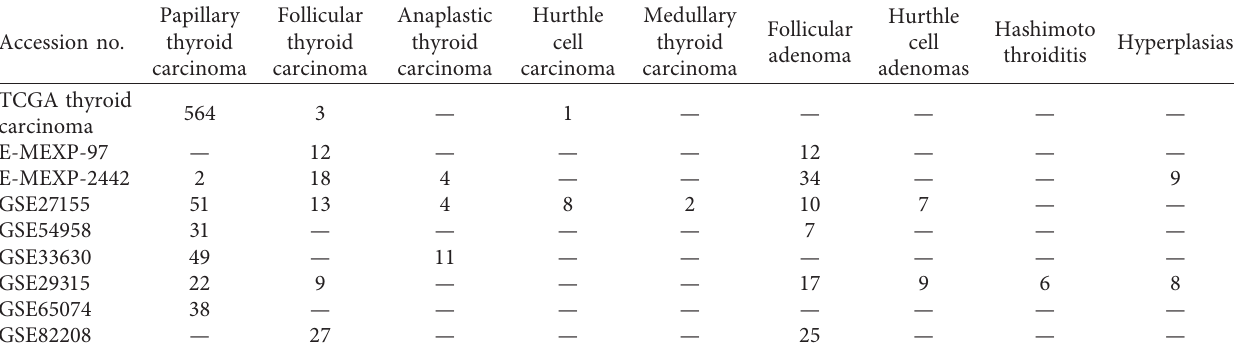
Table 2: Pathology of the samples from different